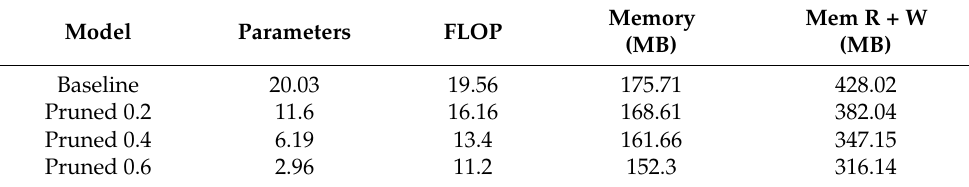
Table 3. Comparison of evaluation indexes of network model